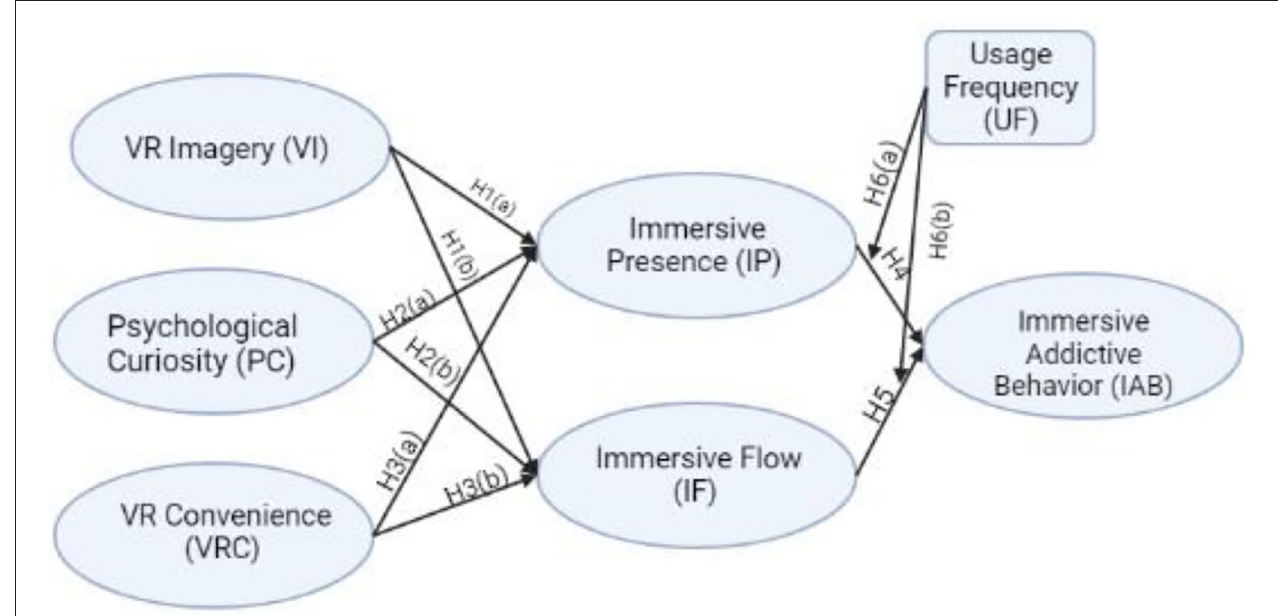
FIGURE 1 | Proposed model of the study.